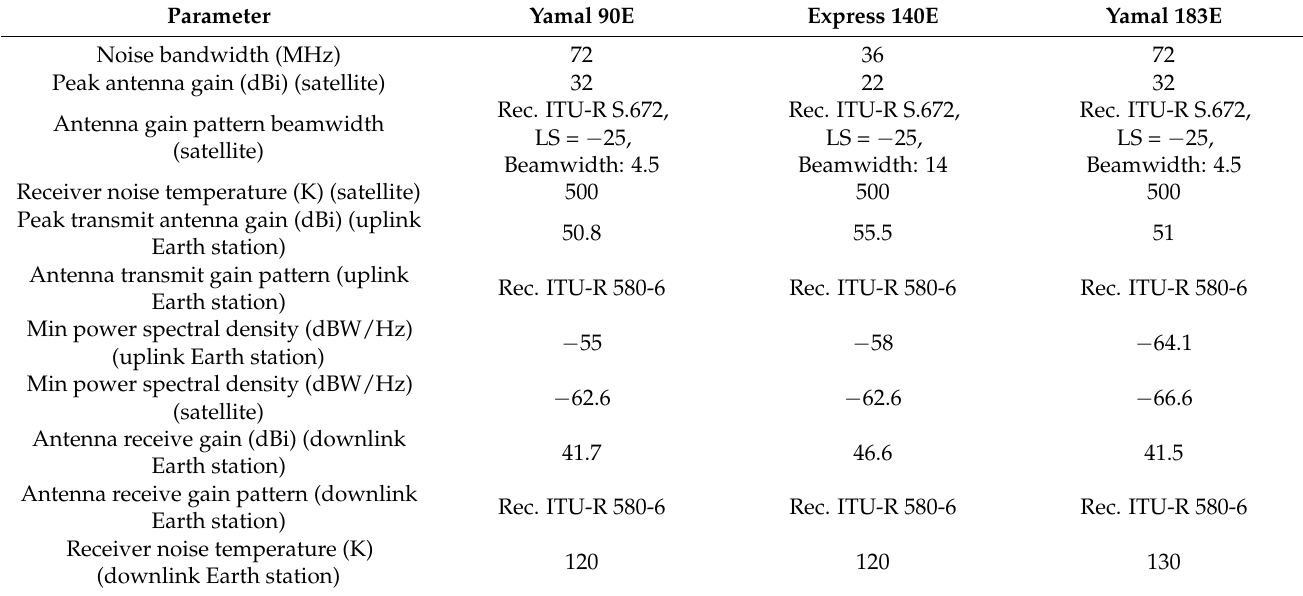
Table 1. Characteristics of the satellite transponders used in